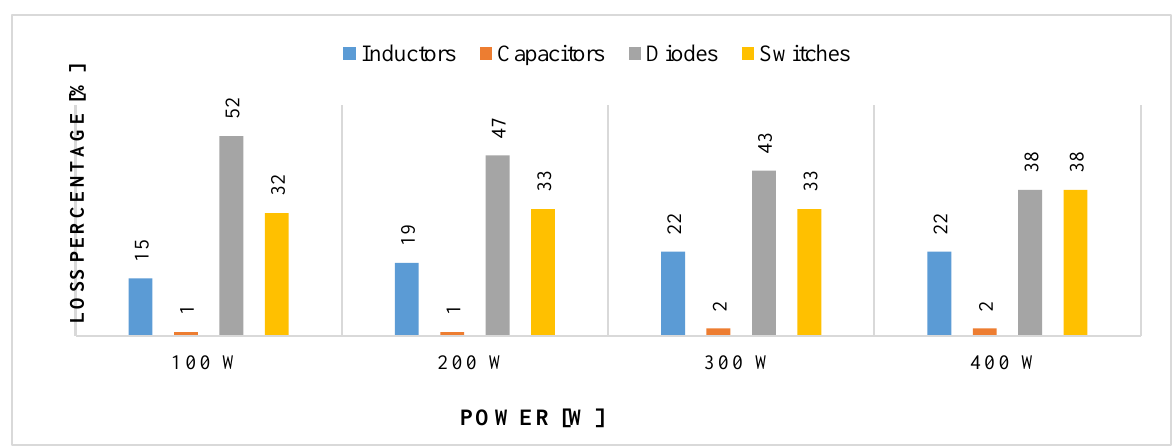
Figure 24. Power loss distribution for elements of a converter.